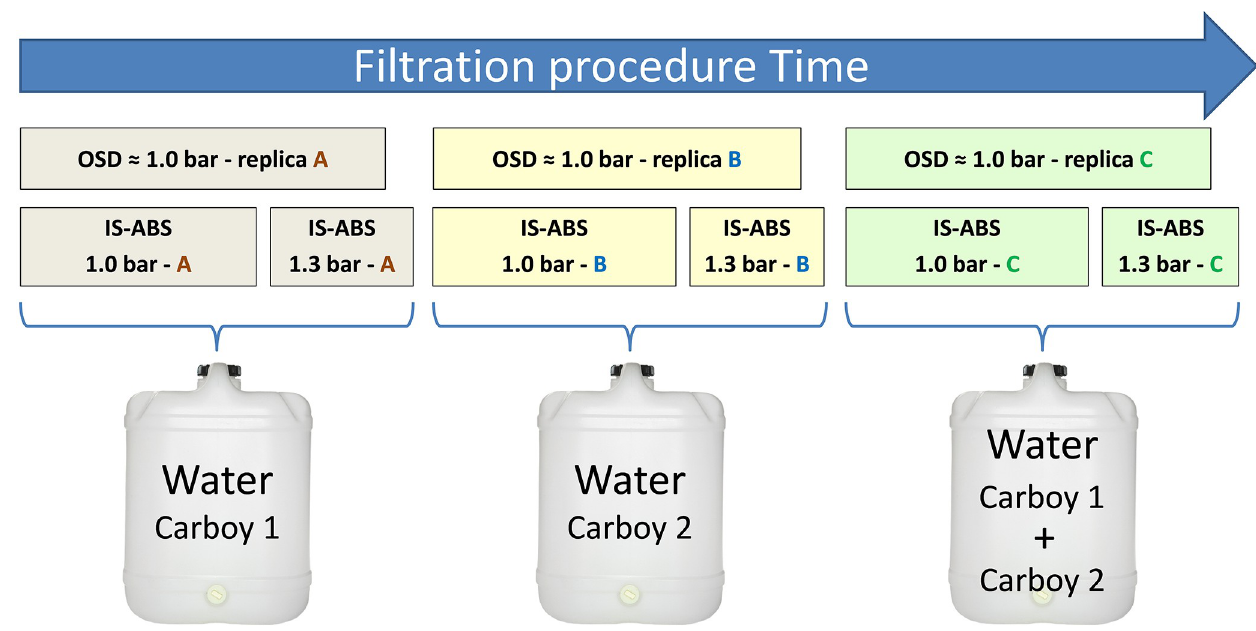
Fig 7. Filtration procedure design. The filtration of the different replicates started simultaneously in the OSD procedure and in the IS-ABS in the different carboys.